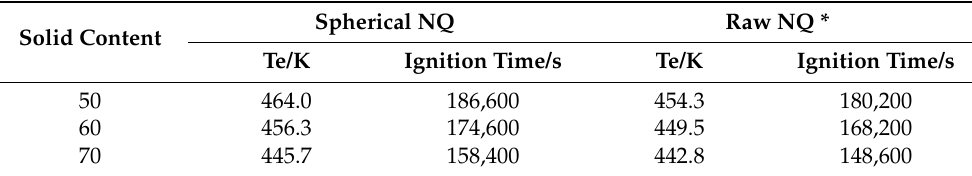
Table 5. Slow cook-off simulation results of NQ-based melt-cast explosives with different charge for-